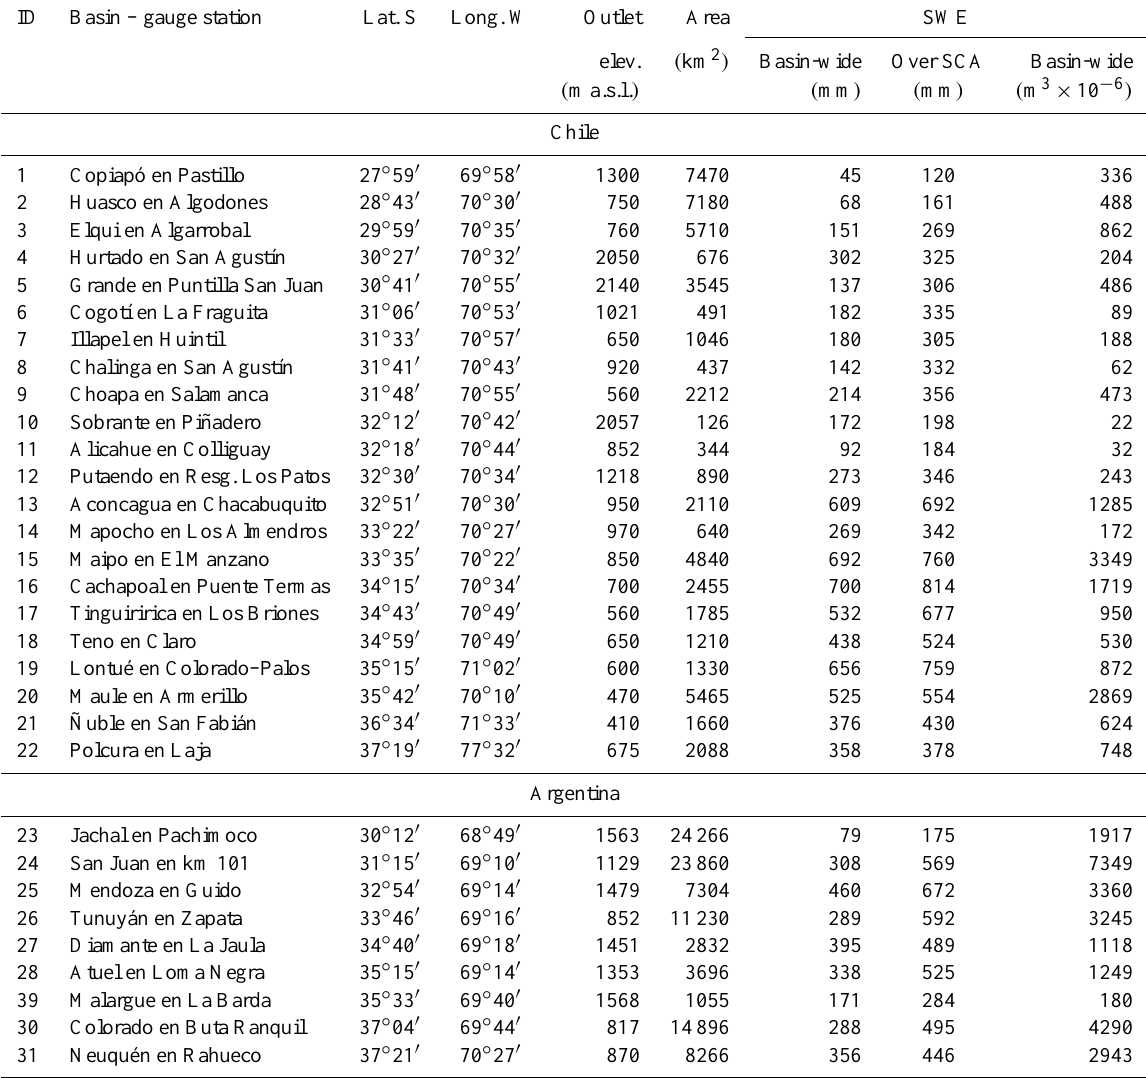
Table 6. Peak SWE 2001–2014 climatology for river basins within the study region. Basin-wide averages, SCA-wide averages and basin- wide water volumes